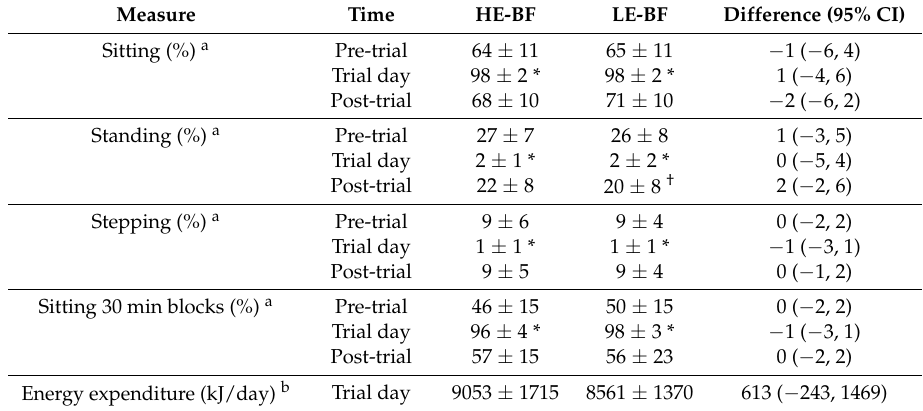
Table 2. Measures of activity calculated from activity monitors worn by individuals with prediabetes ( n = 13) in response to a high-energy first meal (HE-BF) or a low-energy first meal (LE-BF). Measure